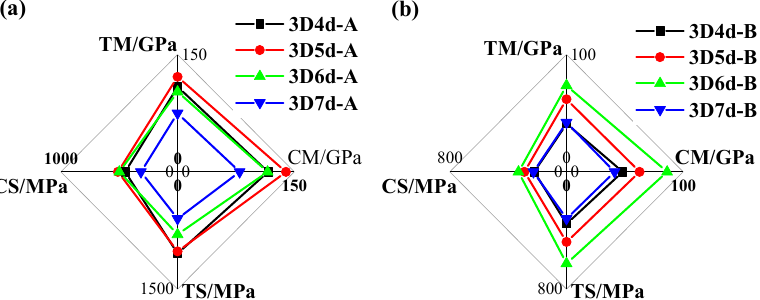
tensile and compressive strengths, as well as tensile and compressive modulus of the 6d ‐ B, were the highest, while those values of the 4d ‐ B and 7d ‐ B were the lowest. The strength and modulus of the T ‐ 6d ‐ B were 50% higher than those of the 4d ‐ B and 7d ‐ B. The com ‐ parison between the moduli and strengths of the 5d ‐ A specimens and the 6d ‐ B specimens, which are the best candidates in their corresponding group, shows that the 5d ‐ A specimen presented the best performance.